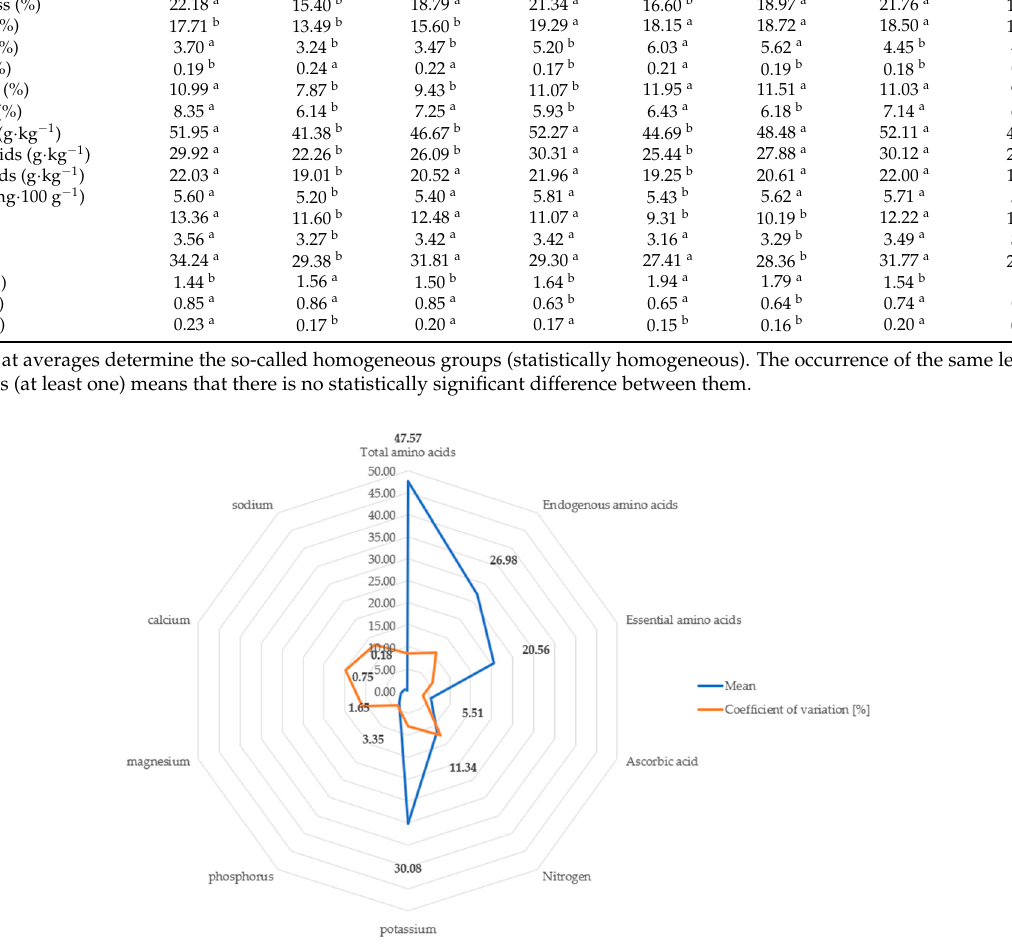
The genetic properties of the tested cultivars significantly influenced all the traits of chemical composition of the tubers (Table 4). Table 4. Chemical composition of H. tuberosus tubers depending on geographic location and cultivars (2015–2017 average).